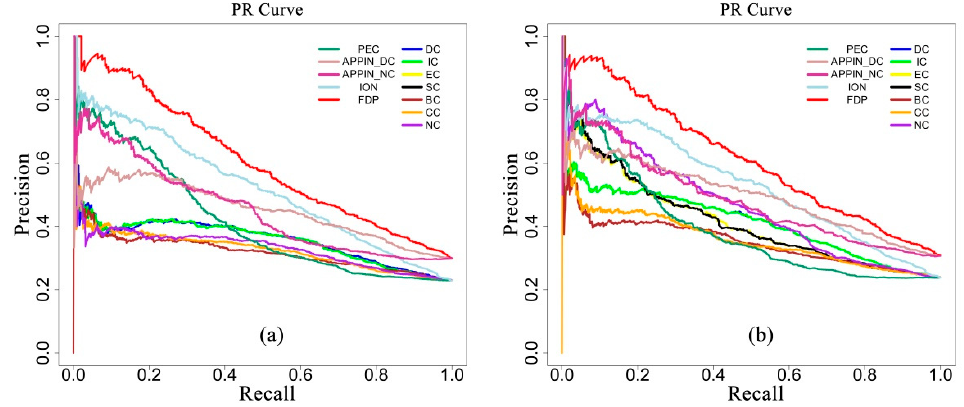
Figure 5. Precision-recall (PR) curves of the FDP and other existing methods based on the DIP_PPI network ( a ) and SC_net network ( b ).